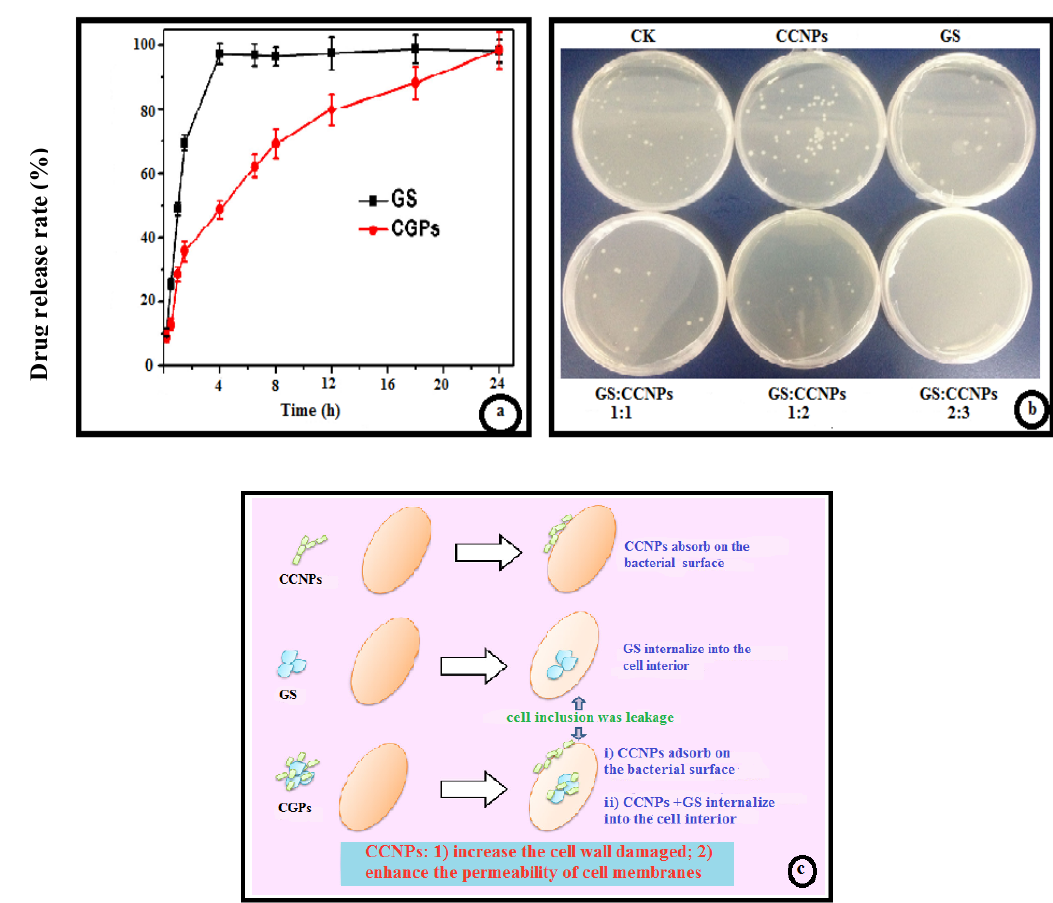
Figure 16. ( a ) The in vitro release profiles of the drug (GS concentration). ( b ) The colonies of B. subtillis treated by CCNPs, GS, and CGPs. ( c ) Schematic representation of the synergistic antibacterial mechanism between nanoparticles aggregates and drugs [68] . Adapted with permission from ref. [68] . A 2018 Creative Commons Attribution (CC BY) license.